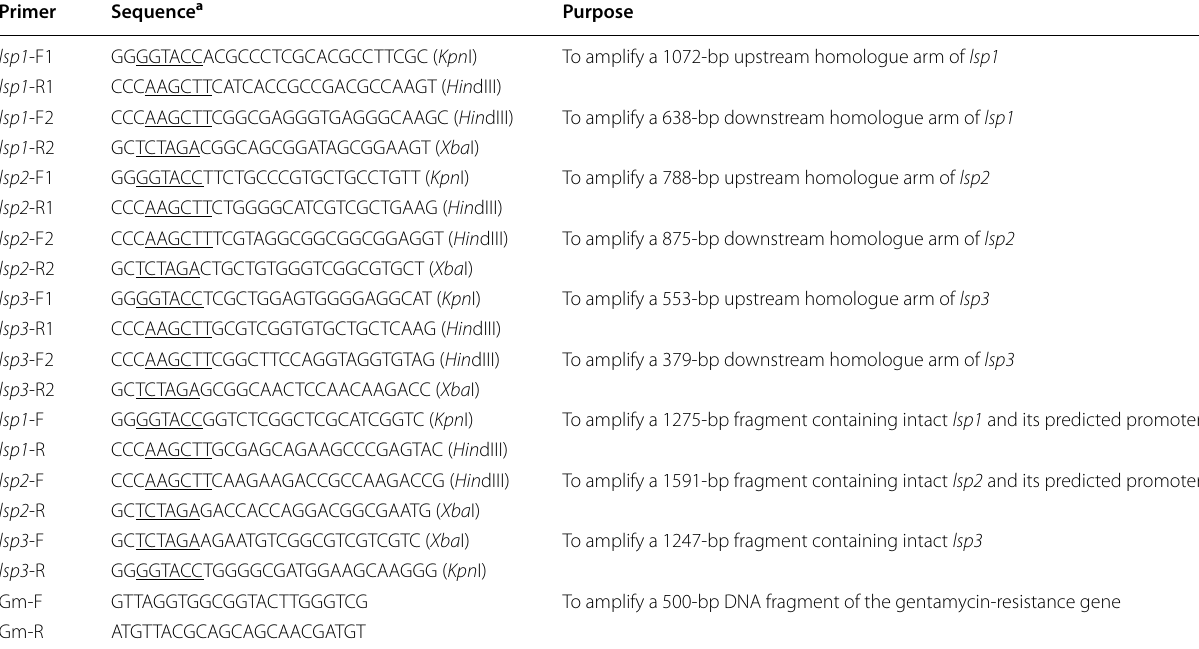
a Restriction enzyme digestion site are underlined